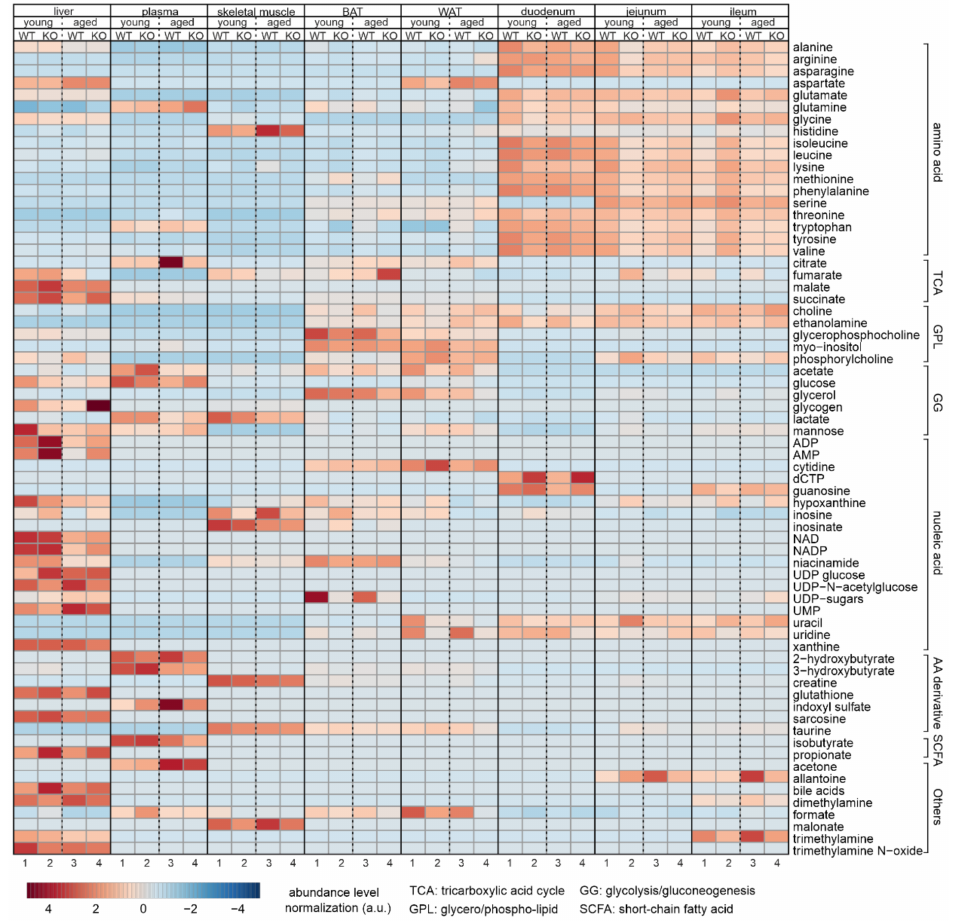
Figure 9. Heatmap showing the average of quantified metabolites within each group of tissues. Type of tissue, status (young or aged), and genotypes are indicated on the top, and numbers of group are shown below. Each line corresponds to a specific metabolite labeled on the right. Each single cell represents the average value calculated from all the relative abundances of the corresponding metabolites within the group. Each of the 4 groups from the same tissue are normalized to enable a comparison. Metabolites at higher concentrations and lower concentrations are in red and blue,